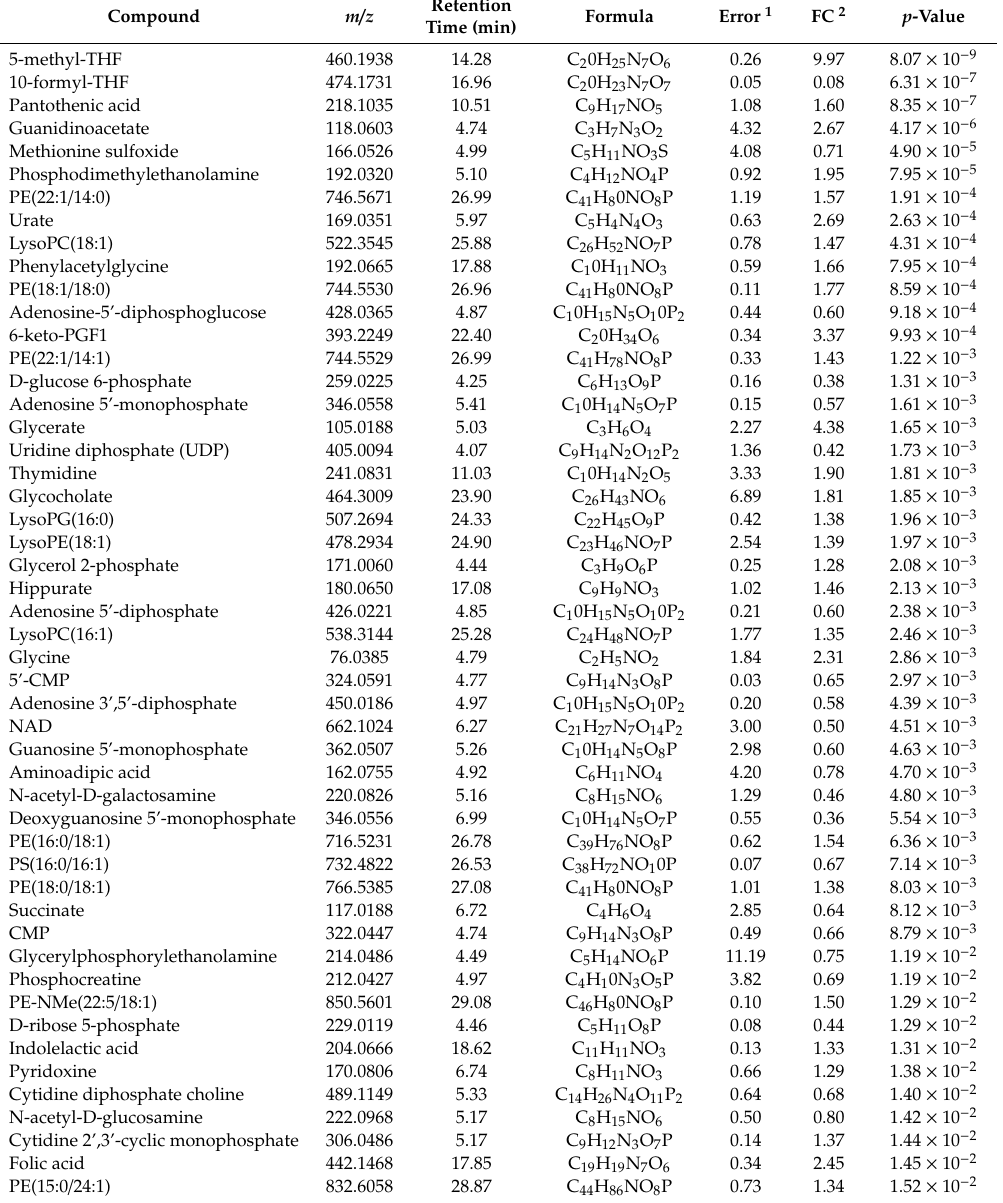
Table 1. Top 50 annotated compounds (one-way ANOVA followed by Tukey’s HSD (honestly significant di ff erence) post-hoc analysis and Holm FDR (false discovery rate) correction; FC > 1.2, p ≤ 0.005) sorted by the significance of p -value for the comparison AA / Control. The complete list for the 204 annotated compounds in alphabetical order is presented in Table